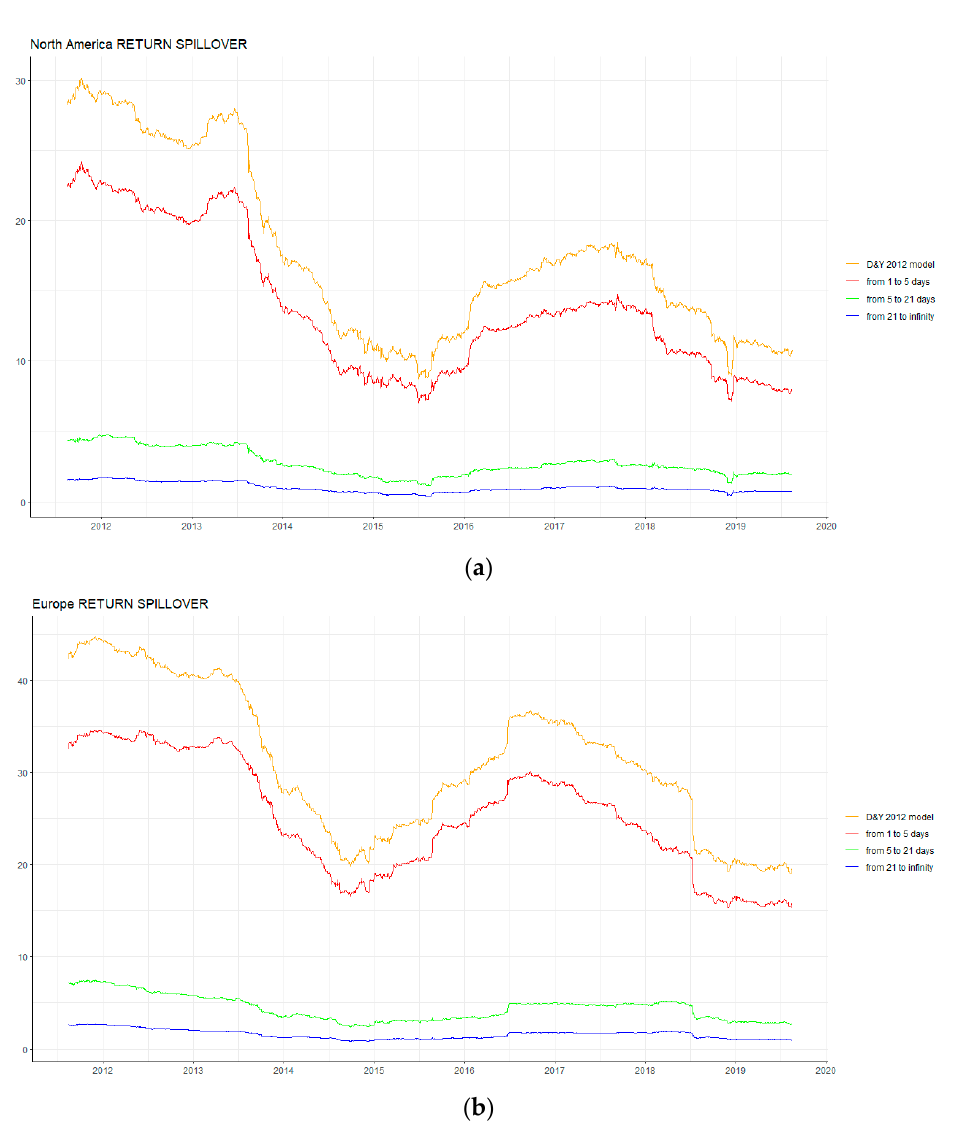
Figure 4. ( a ) The total return spillover of DY12 andBK18 in North America (Windows 500). ( b ) The total return spillover of DY12 and BK18 in Europe (Windows 500). Note: The yellow line indicates the total spillover index of the DY12 model; the red line indicates the total spillover index at “Freq S” of the BK18 model; the green line indicates the total spillover index at “Freq M” of the BK18 model; the blue line indicates the total spillover index at “Freq L” of the BK18 model. The vertical axis variable unit is in